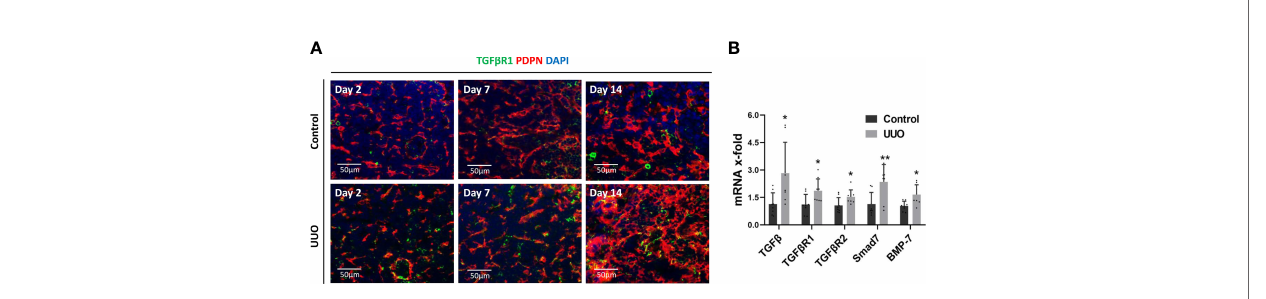
FIGURE 3 | TGF b /TGF b R signaling pathway is active in the UUO KLN. (A) Fluorescence micrographs of UUO and contralateral (control) KLNs demonstrate co-staining (yellow) of TGF b R1 (green) with PDPN + FRCs (red) through Day 14. (B) RT-PCR shows signi fi cantly higher expression of TGF b , TGF b R1, TGF b R2, Smad7, and BMP-7 in UUO KLN than contralateral KLN at Day 7. Each sample was performed in duplication (n=3). Data represented by means ± SEM. *p < 0.05, **p < 0.01.